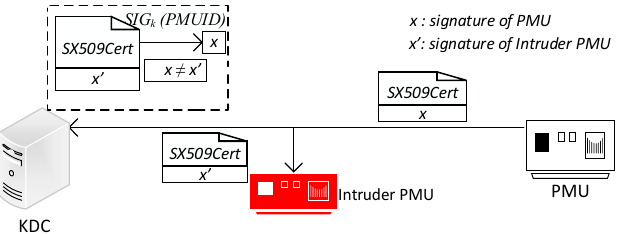
Figure 10. Intruder PMU trying to authenticate itself by changing signature.